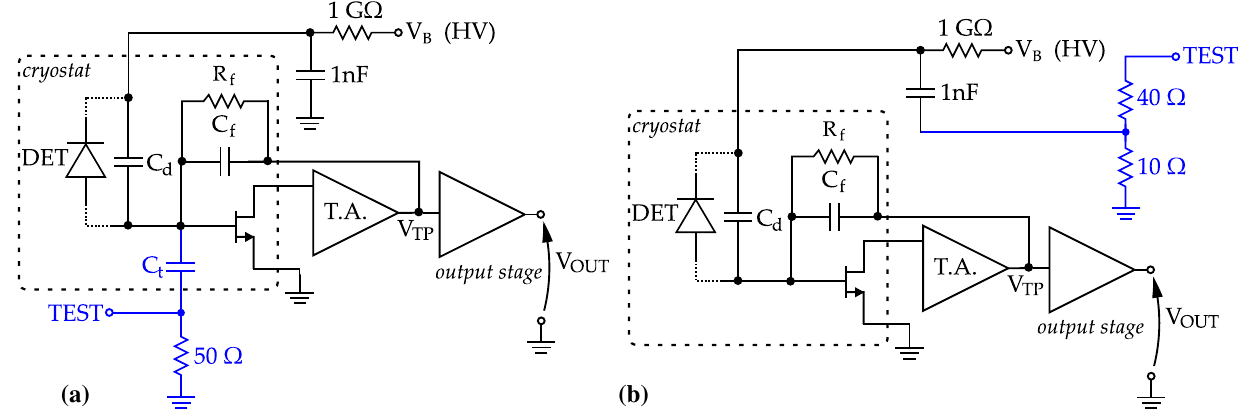
Fig. 4 Left panel a : Standard charge sensitive preamplifier configura- tion with the test pulser (in blue) – the signal is fed through a test capaci- tance C t placed inside the cryostat, close to the input J-FET. Right panel b : Modified test pulser setup for the capacitance measurement. Instead of being fed through the test capacitance C t , the pulser signal is injected